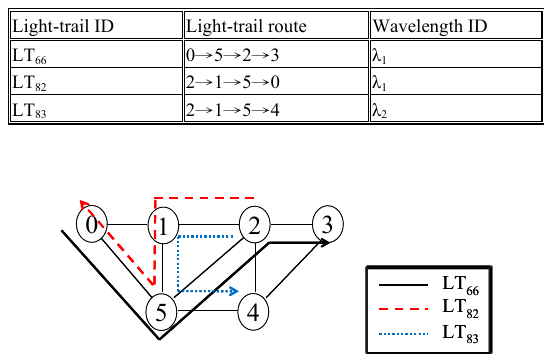
Fig. 8. The illustration of the established light-trails in